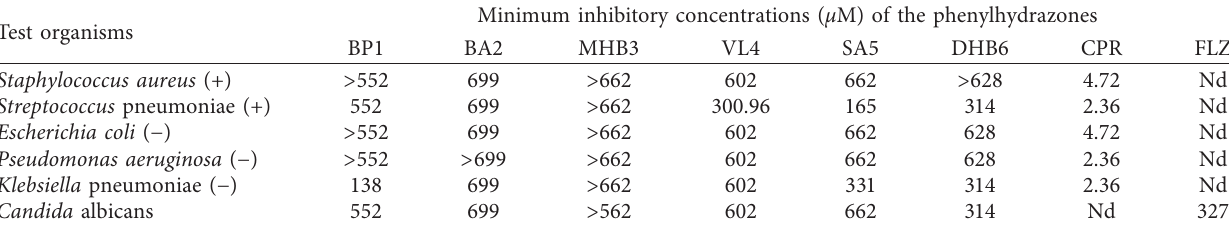
Table 2: Antimicrobial activity of the compounds against the panel of organisms. Test organisms